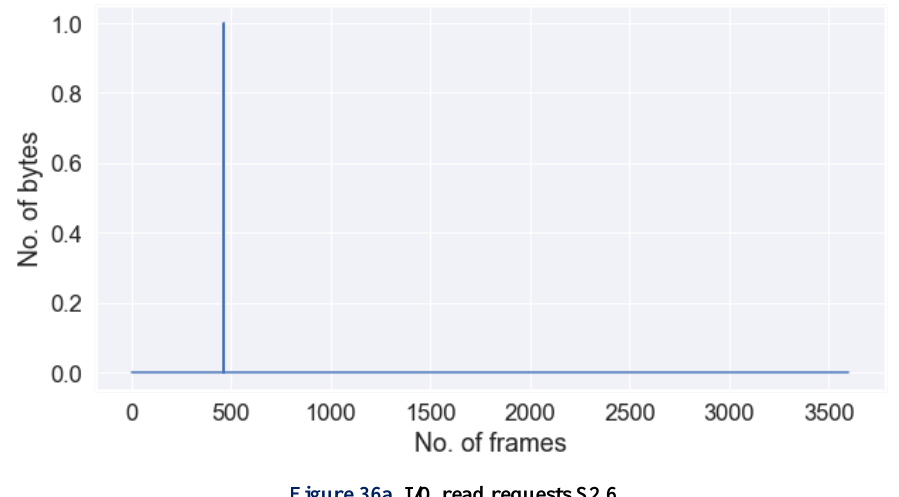
Figure 35b. Network bytes sent in S2.6.